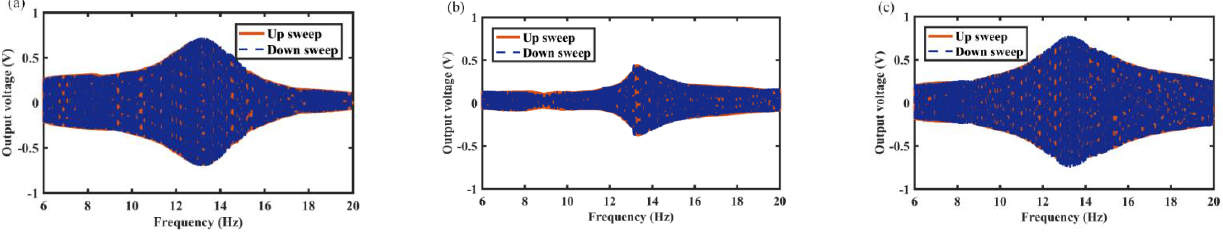
Figure 9. Frequency sweep response of the MCEEH with spring wire diameter of 0.5 mm: ( a ) coil 1; ( b ) coil 2; ( c ) coil 3.